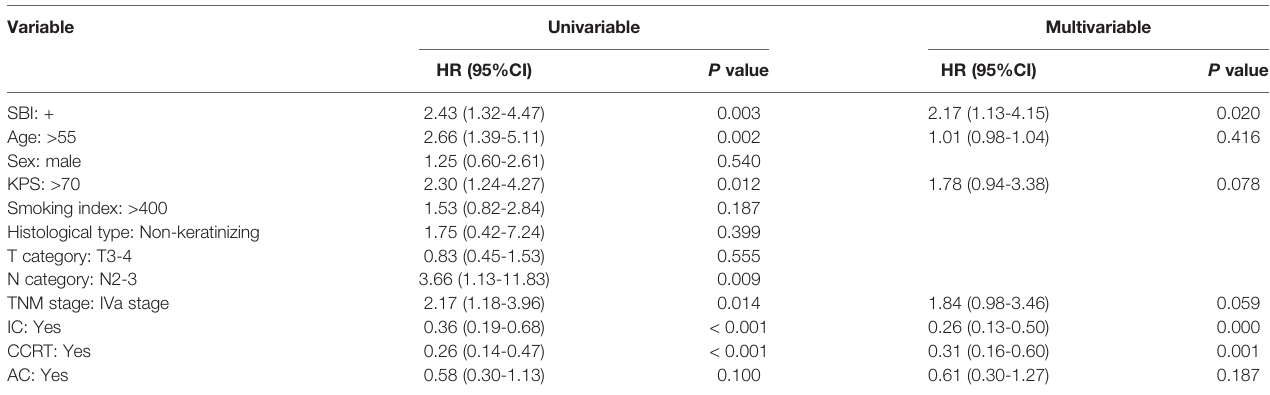
TABLE 3 | Risk factors selected by Cox proportional hazard regression analysis.